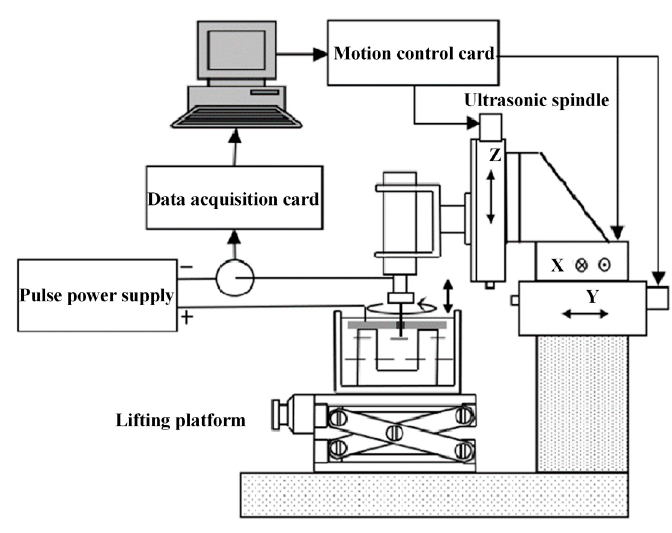
Figure 7. Schematic diagram of the experimental system.